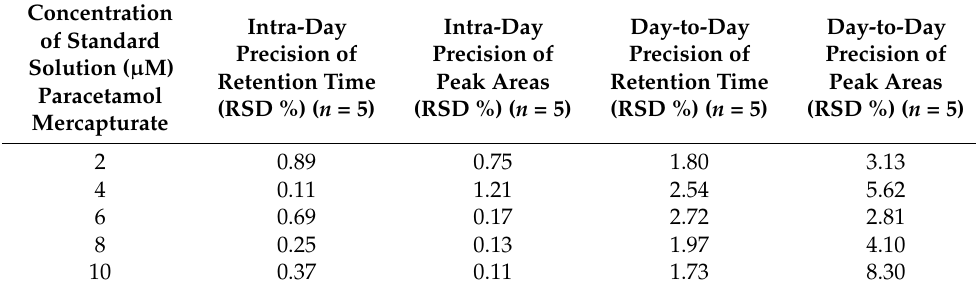
Table A5. Within-day and day-to-day precision of retention time and peak areas of paracetamol mercapturate standard solutions in drug-free intestinal